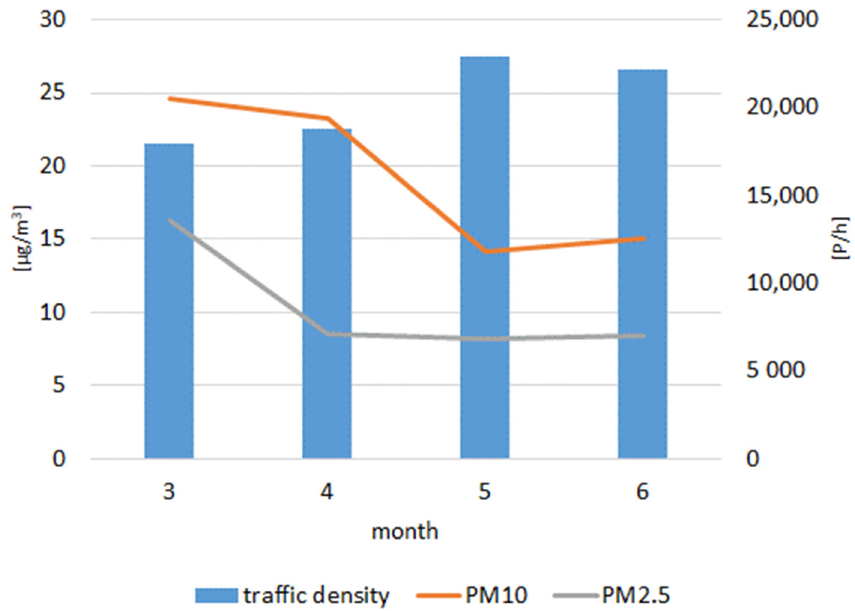
Figure 11. Average number of trips generated in March, April, May and June in Wawer in relation to daily average hourly concentrations of PM2.5 and PM10.